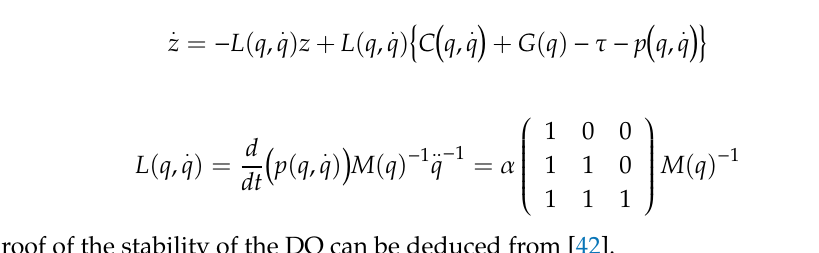
Figure 8. Membership function of the tuned scaling gains: ( a ) K m 1 , ( b ) K m 2 , ( c ) K m 3 . Table 2. Rules table of the fuzzy logic system.